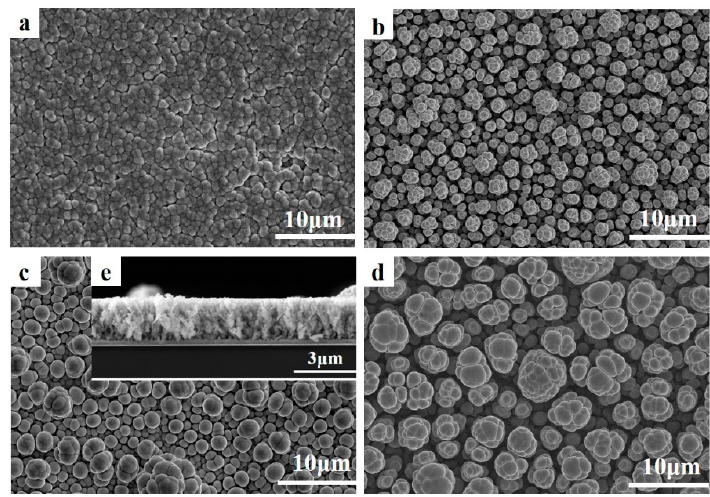
Figure 3. Top-view SEM images of Sb-Te films deposited on Si wafer-based Pt electrode under a constant applied voltage of ( a ) − 100, ( b ) − 200, ( c ) − 300, and ( d ) − 400 mV; ( e ) cross-sectional view of the film deposited at − 300 mV.